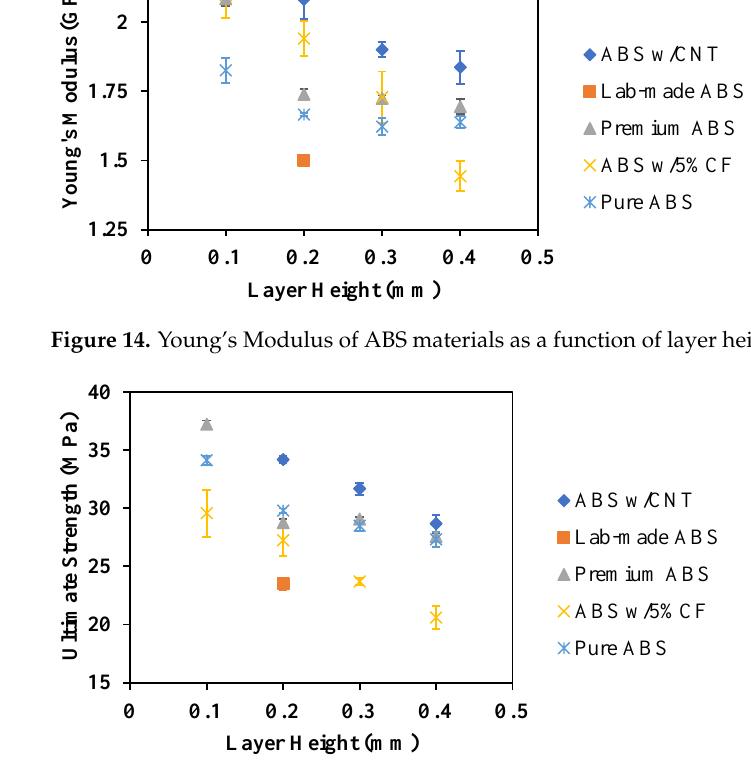
Figure 15. Ultimate strength of ABS materials as a function of layer